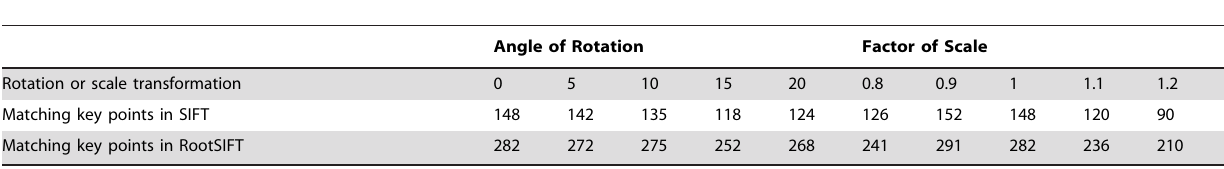
Table 1. Robustness of SIFT and RootSIFT against rotation and scale